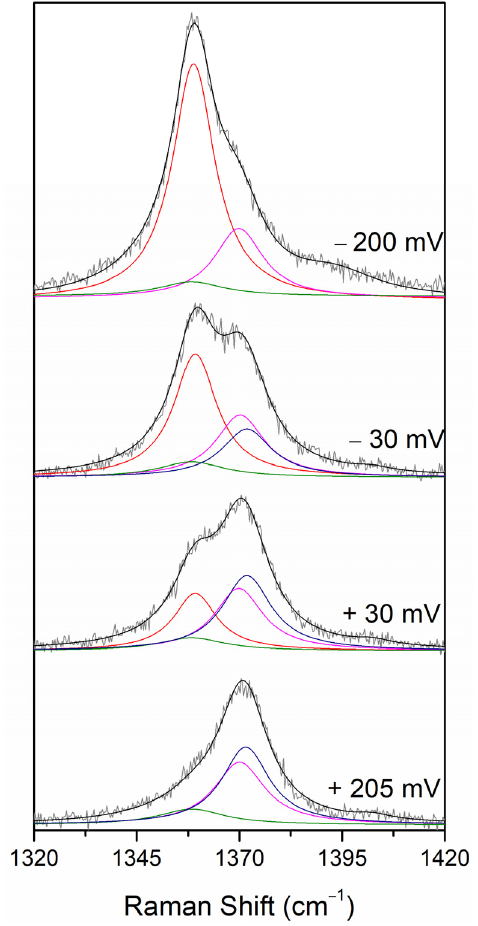
Figure 4. The ν 4 band region of the SERR spectra of CboDyP immobilised on Ag electrodes coated with 1-undecanethiol and 11-amino-1-undecanethiol hydrochloride SAM (M:M, 2:1), recorded at several selected electrode potentials. The component spectra represent the overall fit (black) and ferric 6cHS (blue), ferric redox-inactive 5cHS (magenta), ferrous 6cHS (red) and ferrous redox-inactive (green) species. Spectra were obtained with 405 nm excitation at pH 7 and 21 ◦ C ( vide infra Materials and